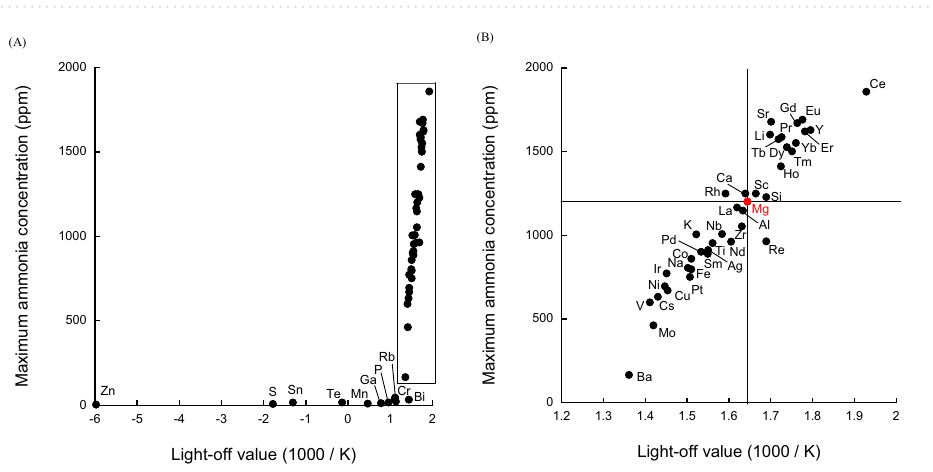
Figure 4. Correlation between maximum ammonia concentration and light-off value. ( A ) All catalysts. ( B ) Enlarged view of the enclosed area in panel ( A ). The elemental symbols correspond to the added